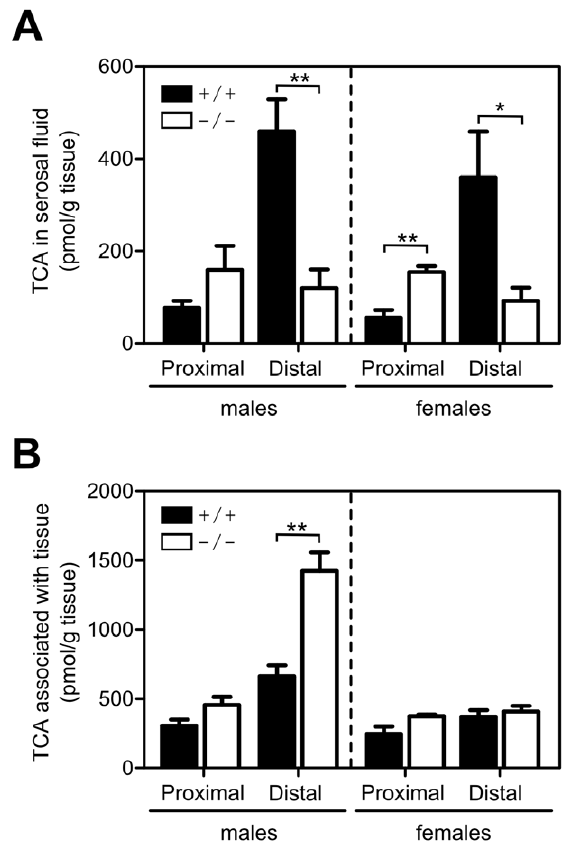
Figure 3. Transport of bile acids in everted gut sacs. (A) Amount of TCA accumulated in the serosal fluid after a 30 min incubation of gut sacs from the proximal one-third and distal one-third portions of the small intestine of male Fabp6 + / + (n=4), female Fabp6 + / + (n=3–4) mice (black bars), male Fabp6 2 / 2 (n=4) and female Fabp6 2 / 2 (n=5) mice (white bars). (B) Amount of TCA accumulated in the gut sac tissue at the end of the assay incubation period. * P , 0.025, ** P , 0.01, vs. wild-type of the same sex.